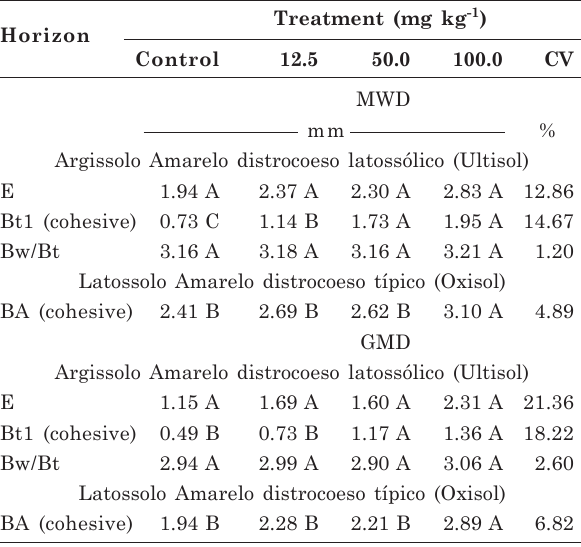
Table 4. Mean weight diameter (MWD) and geometric mean diameter (GMD) of aggregates of the horizons E, Bt1, Bw/Bt (Ultisol) and BA (Oxisol) with the application of aqueous polyacrylamide solutions of (12.5, 50.0 and 100.0 mg kg -1 ) and a control treatment (distilled H 2